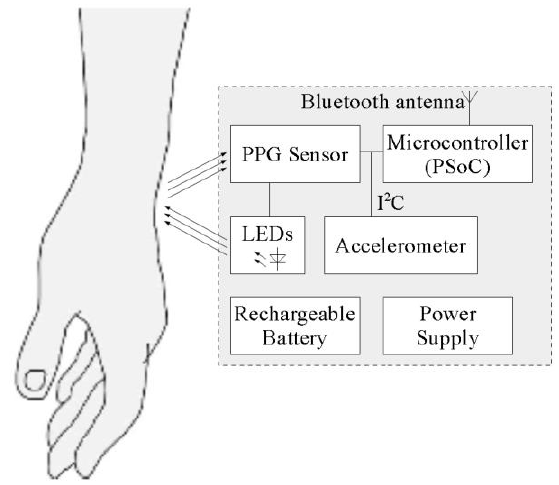
Figure 8. Block diagram of the device implementing the algorithm for measuring the heart rate.